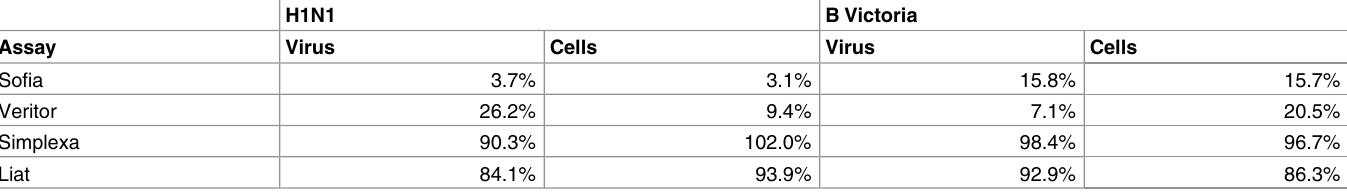
Table 8. Comparing the effect of SRS versus PBS on the detection of infected cells or cell free virus (analytes). (SRS Value/ PBS